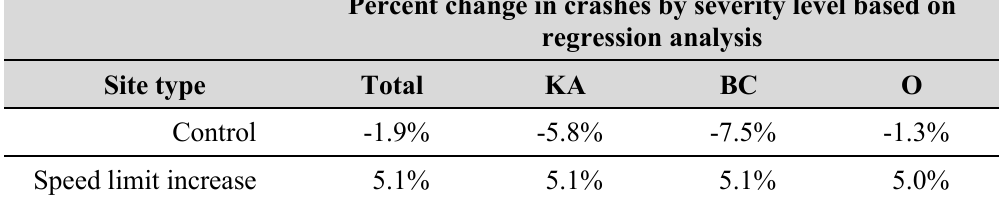
Table 3 Percent change in crashes from before-period to after-period by severity level and site